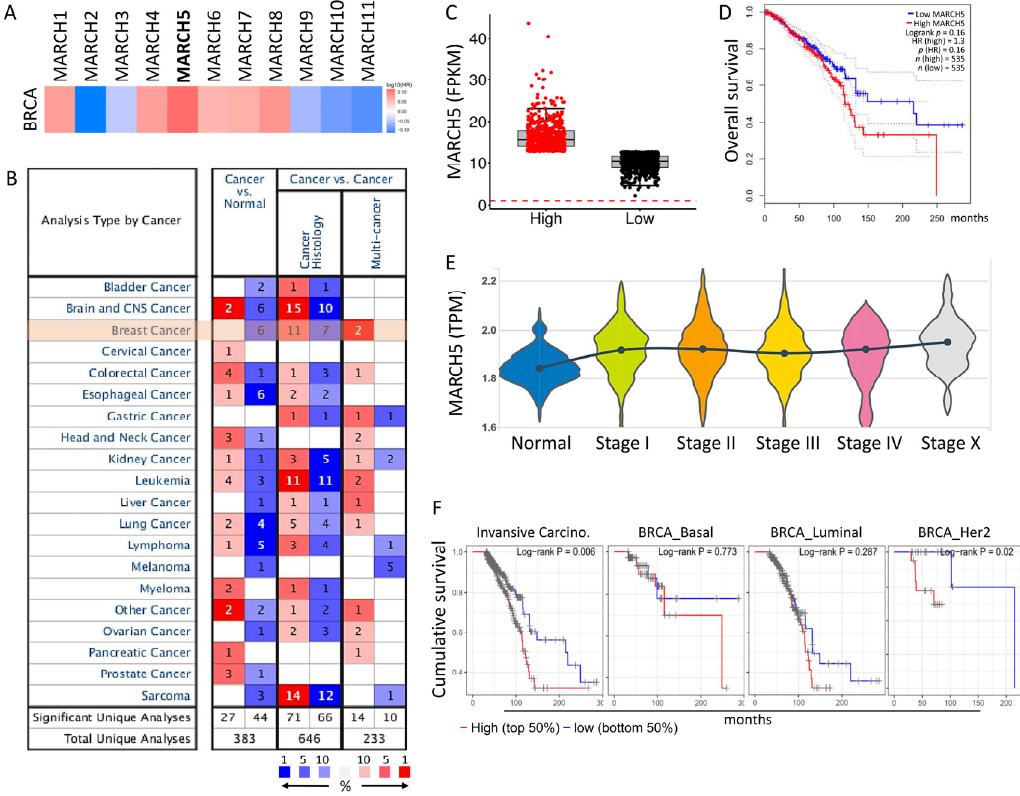
Figure 3. MARCH5 expression levels in different human cancers and survival curves comparing the high and low expression in TCGA database. ( A ) GEPIA2 software analyzed the expression of MARCH family genes and the overall survival of breast cancer in TCGA. ( B ) The expression of MARCH5 in different cancer tissues compared with normal tissues. The number in each cell is the number of datasets. The datasets were obtained with the following parameters: p -value threshold of 0.01. ( C ) Box plot showing the expression levels of the epigenetic regulatory genes in BRCA. ( D ) Overall survival analyzed using the Kaplan–Meier method with log-rank testing according to MARCH5 expression. ( E ) Violin plot showing the expression levels of the MARCH5 in different stages of BRCA. ( F ) Analysis of survival rates of different types of breast cancer based on TCGA database.